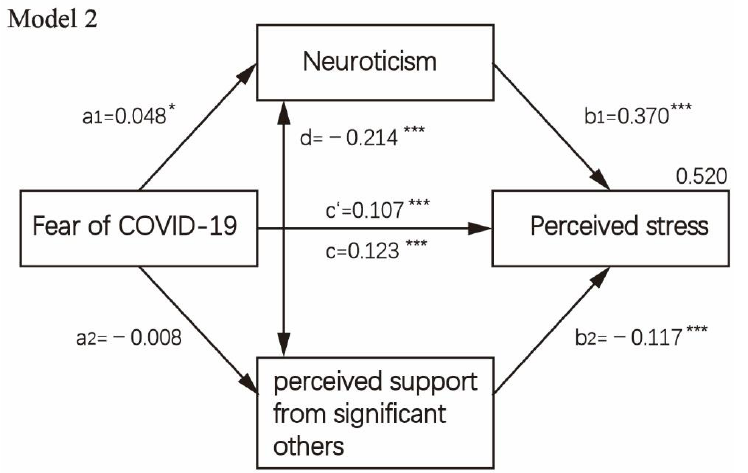
Figure 3. Mediation analysis test on fear of COVID-19 concerning perceived stress and mediating role of neuroticism and subscale of perceived social support from significant others and controlling covariates, i.e., age, sex, education level, religion, occupation status, history of chronic non-communicable disease and quarantine status ( n = 3299). Note: * p < 0.05; *** p < 0.001.